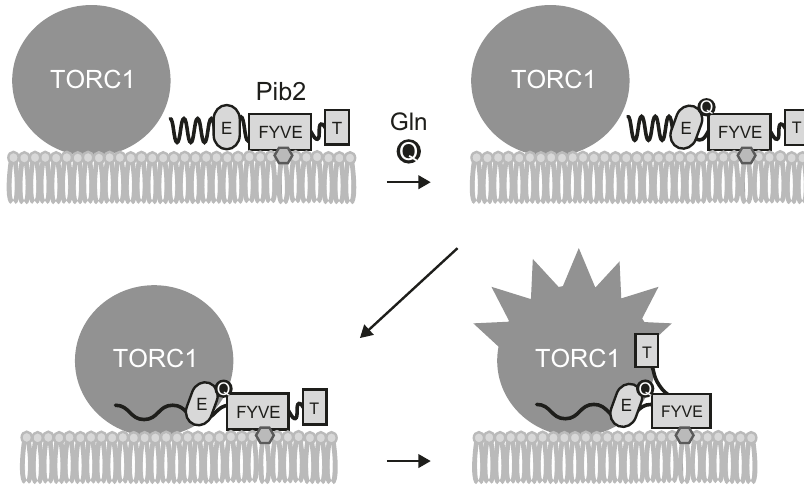
Fig. 6 A model of Pib2-dependent TORC1 activation in response to glutamine. See the discussion section for details.